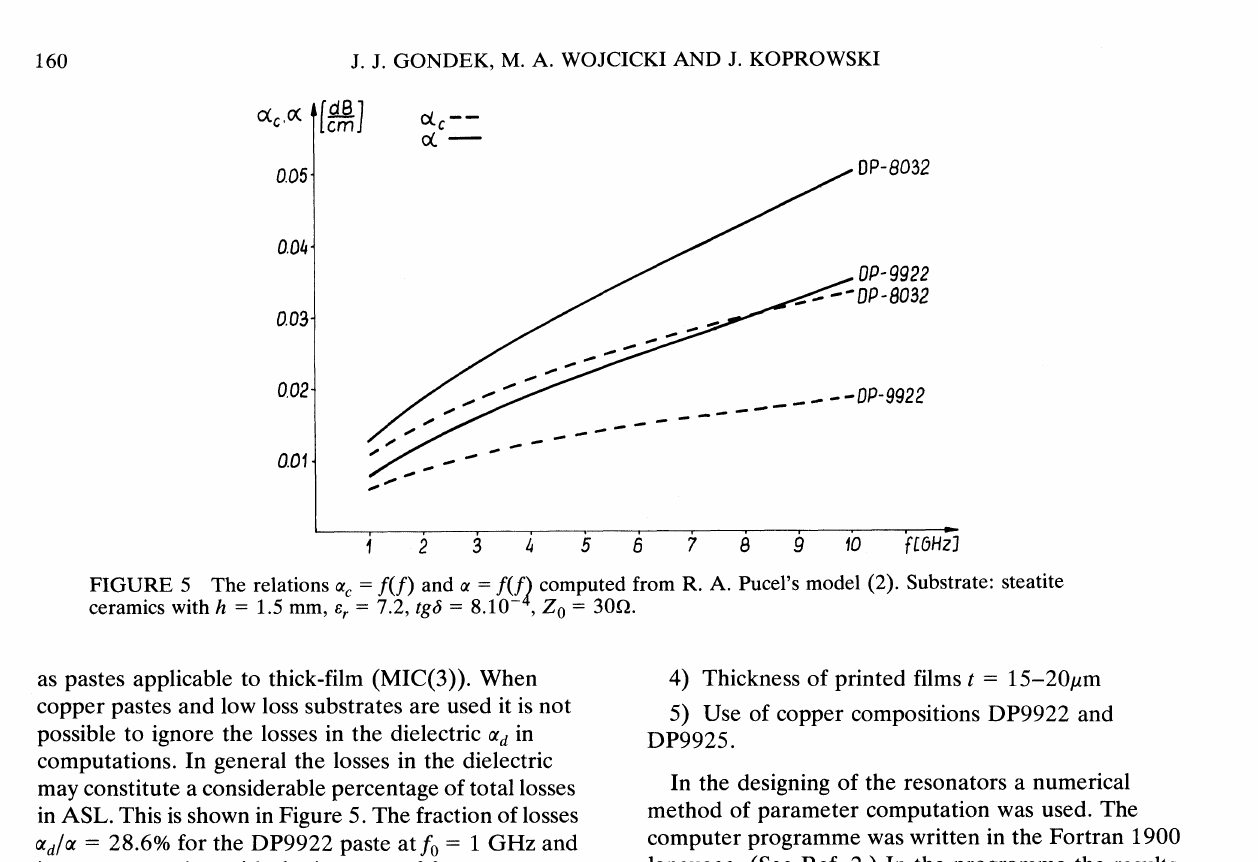
FIGURE 5 The relations % f(f) and f(f) computed from R. A. Pucel’s model (2). Substrate: steatite ceramics with h 1.5 mm, 7.2, tg6 8.10 -’, Z 0 30.